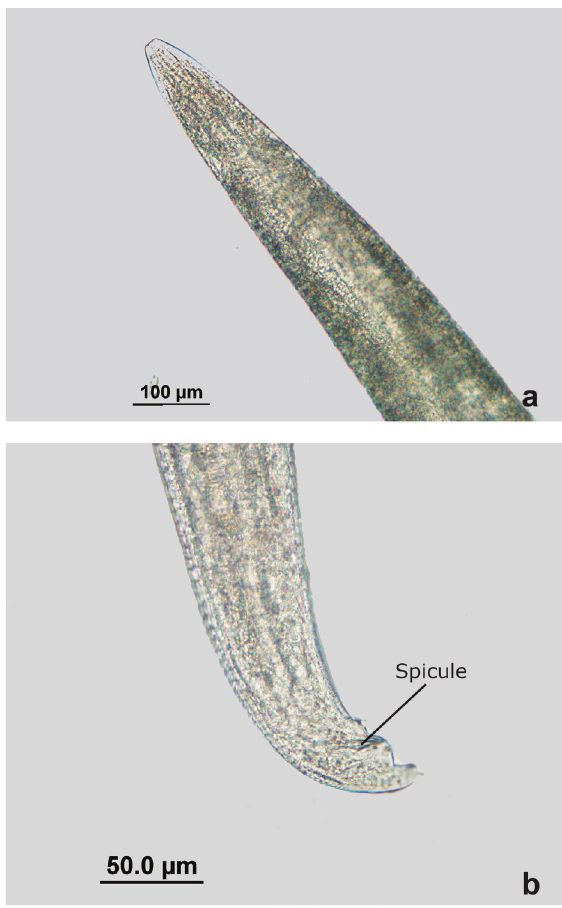
Figure 5 - Cameronia arecoensis . a. Male, cephalic region. b. Posterior region (line showing the